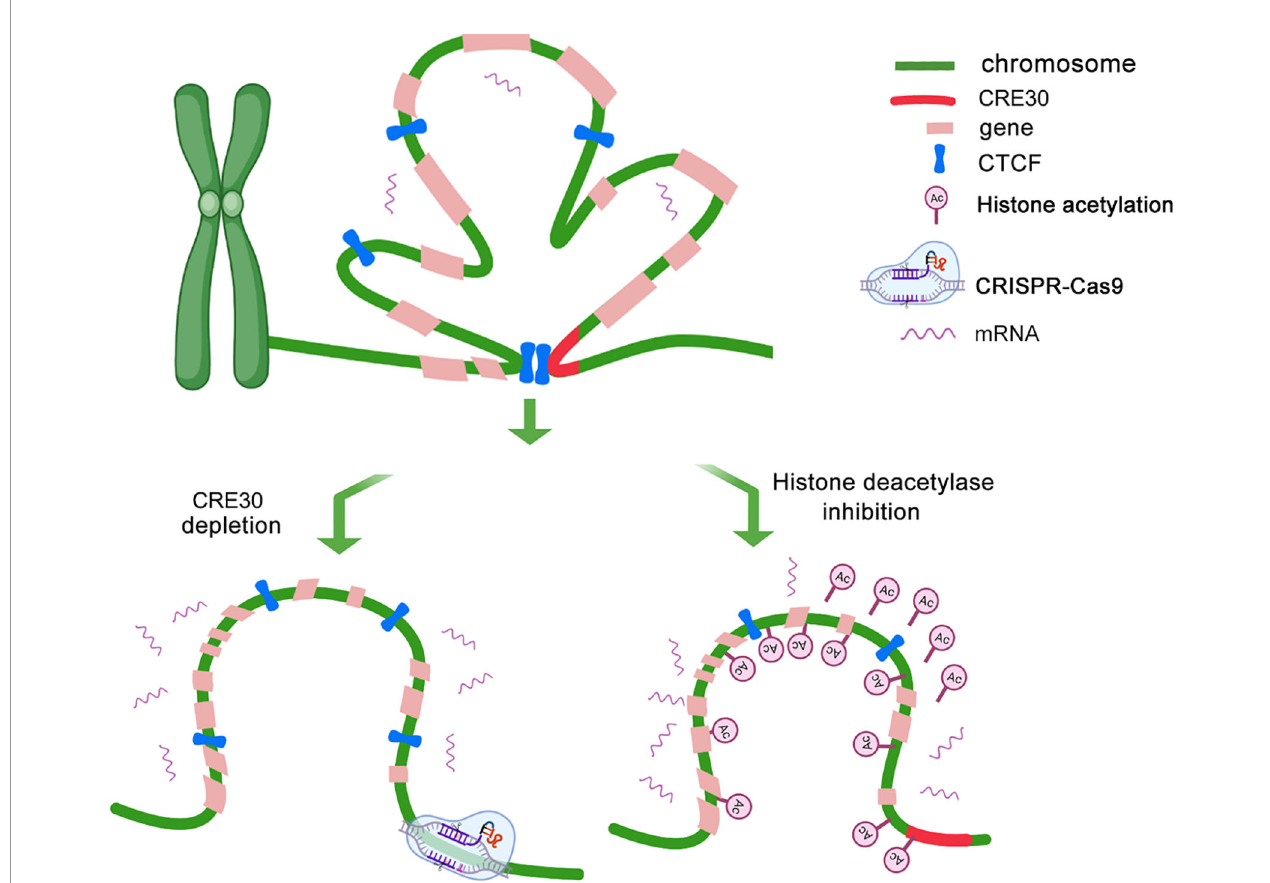
FIGURE 7 | CRE30 collaborating with histone deacetylation maintains high-order chromatin organizations that affect gene expressions. A schematic for the potential model of expression regulation and chromatin architecture modulation in sub-CRR regions is shown. Top panel: in the sub-CRR region, CTCF is recruited on the CRE30 locus, and chromatin loops are maintained in sub-CRR regions, leading to compact 3D chromatin architecture, thereby limiting the gene regulation scope. Bottom left: CRE30 deletion abolishes CTCF binding, and chromatin loops are disrupted accompanied with gene regulation activation. In the bottom right model, increase in histone acetylation leads to disruption of CTCF binding on some sub-CRR locus and destruction of chromatin loops, which is further linked to active gene